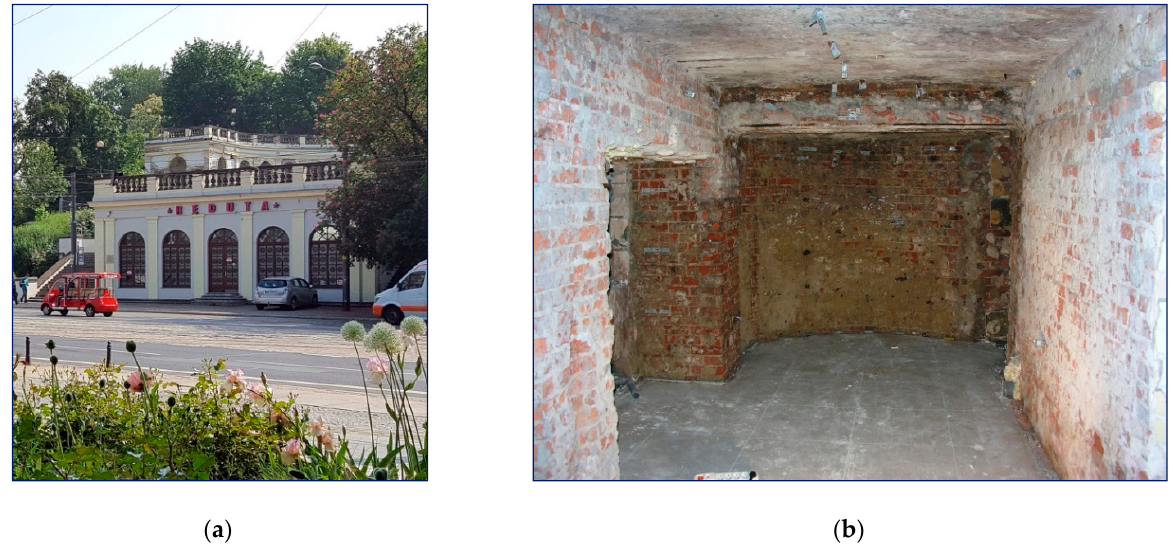
Figure 4. View of the peristyle pavilion: outer facade ( a ) and the internal surface of the brick wall covered with crystallized salts and mold fungi ( b ).